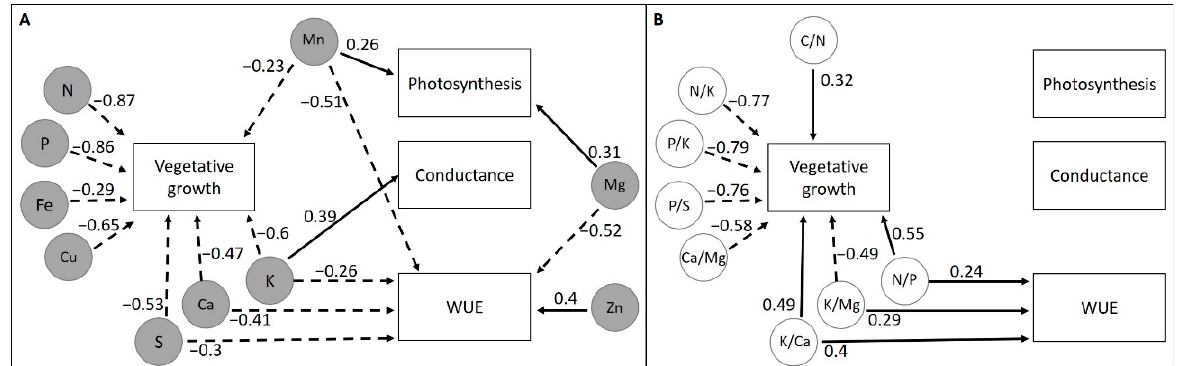
Figure 6. Correlations of ( A ) nutrients and ( B ) nutrient ratios with photosynthesis ( A ), stomatal conductance (g s ), water use efficiency (WUE), and vegetative growth of the four perennial Mediterranean grasses assayed. Only significant correlations are shown. Solid and dotted arrows denote positive and negative correlations, respectively. Values next to arrows are the correlation values.